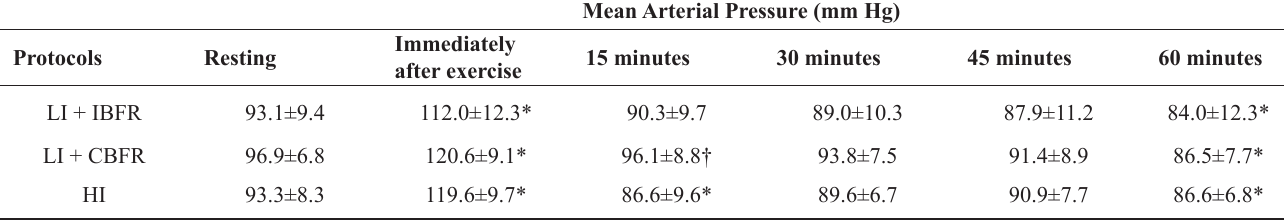
Table 3. Comparative analysis of mean arterial pressure between the study